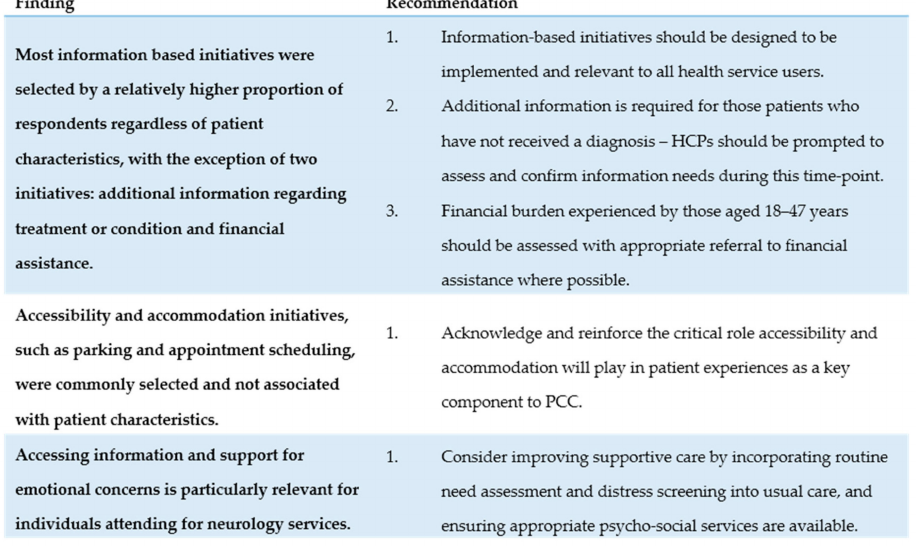
Figure 2. Summary of findings and related recommendations for health services and